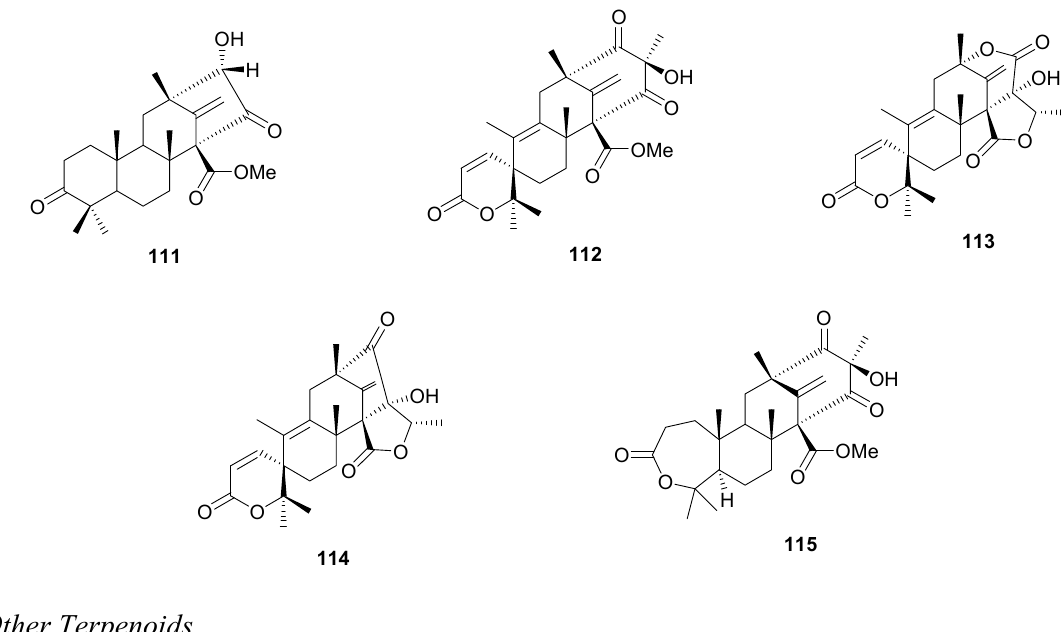
Figure 3. Chemical structures of meroterpenes from endophytic